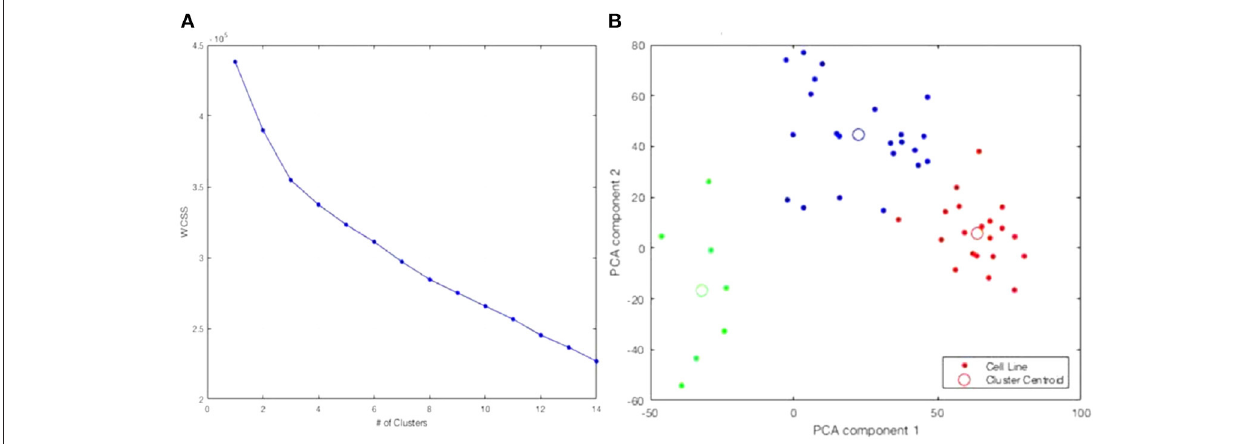
FIGURE 3 | Re-analysis of the 49 cell lines identifies three clusters. (A) WCSS error. (B) PCA plot of 3-clusters of 49 cell lines with 19 K gene expression features: Cluster 1, Cluster 2, Cluster